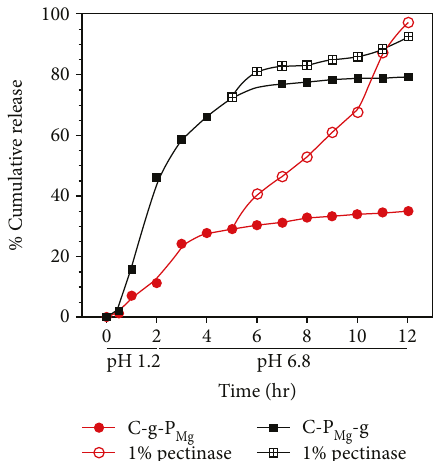
Figure 4: Curcumin release (%) pro fi les of C-g-P ( fi lled circle) Mg prepared by method A and C-P -g ( fi lled square) prepared by Mg method B in the absence of pectinase. The release pro fi les of C-g- P (open circle) and C-P -g (crossed square) in the presence of Mg Mg pectinase from the 6th hour.